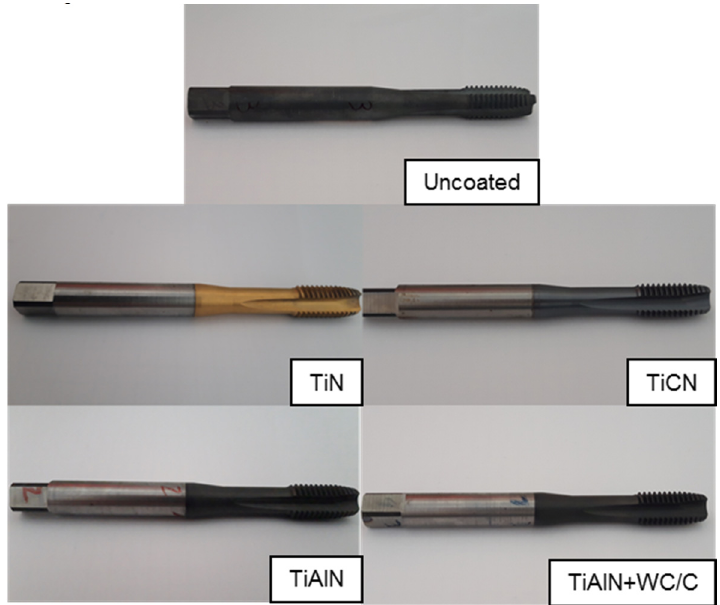
Figure 4. Uncoated tap and di ff erent coating taps used in threading tests.